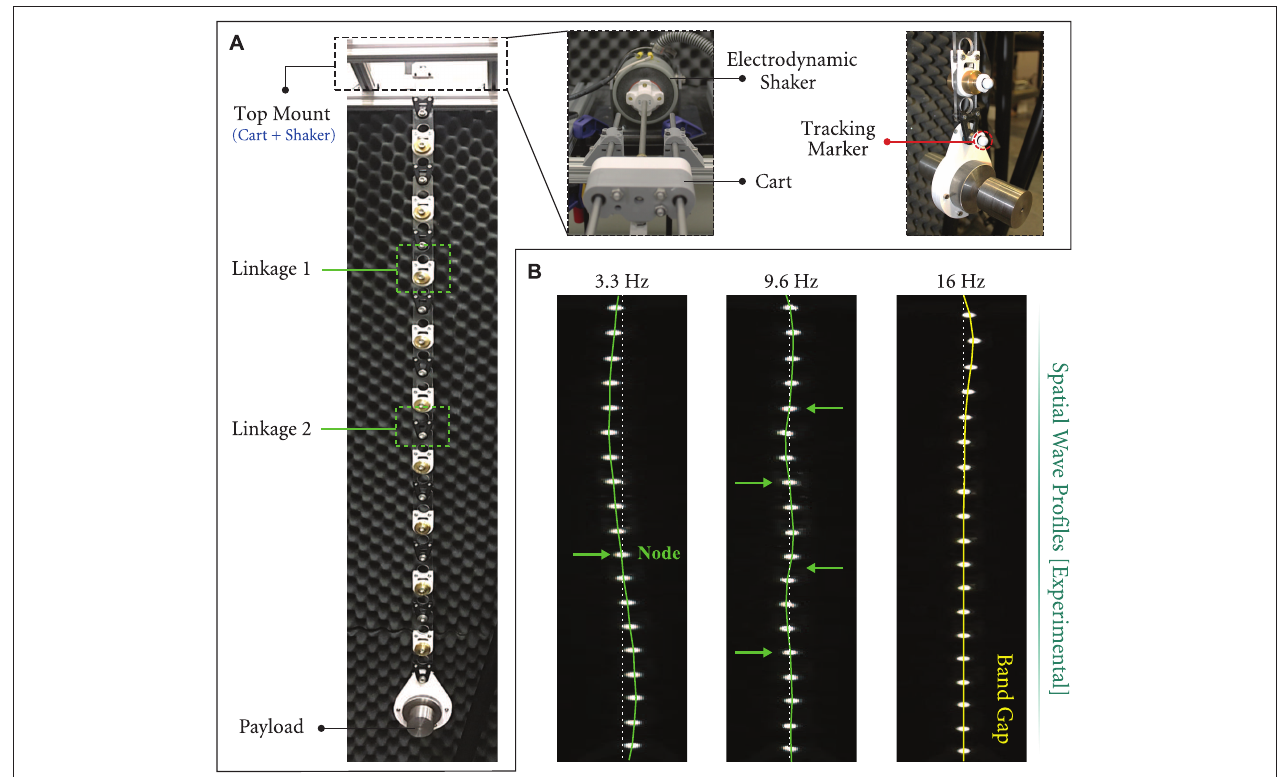
FIGURE 6 | (A) Front view of the fully assembled pendulum chain (left). Close-ups of the mounting system, electrodynamic shaker, cart as well as the linkages with the attached reflective markers (right). (B) Experimental snapshots of the spatial wave profiles outside (3.3 and 9.6 Hz) and inside (16 Hz) a band